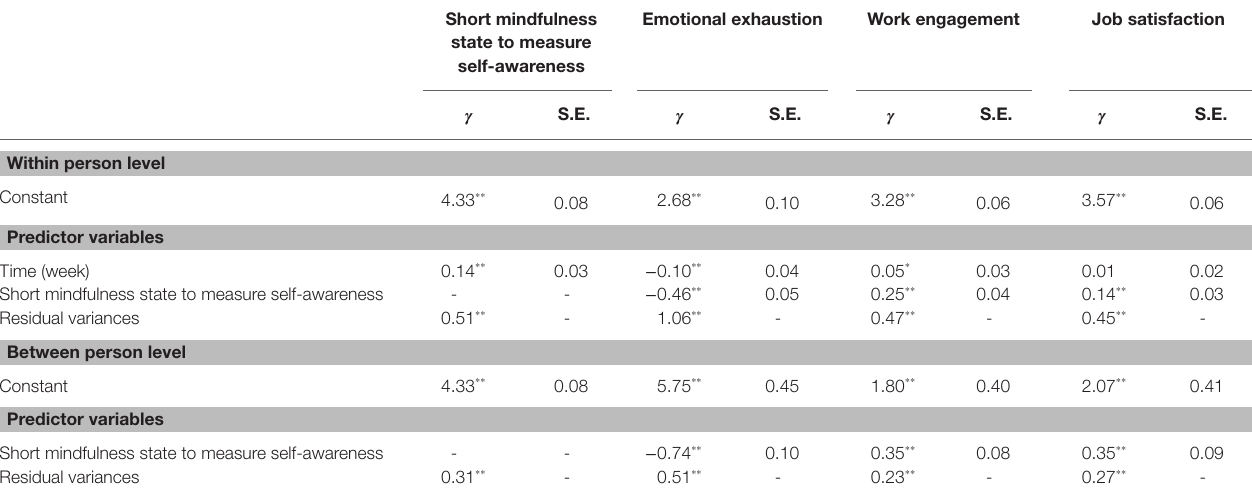
TABLE 4 | Multilevel regression analyses: time predicting weekly mindfulness, emotional exhaustion, work engagement, and job